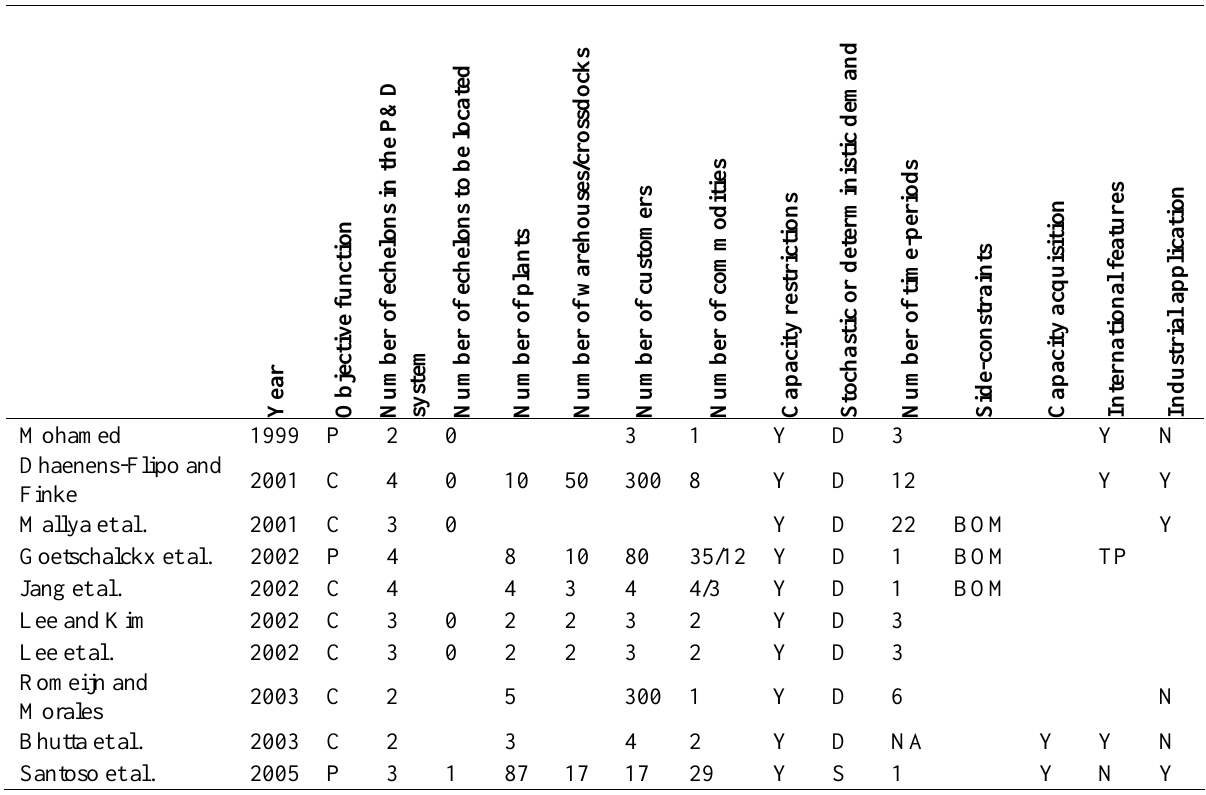
Table 4. Production-distribution